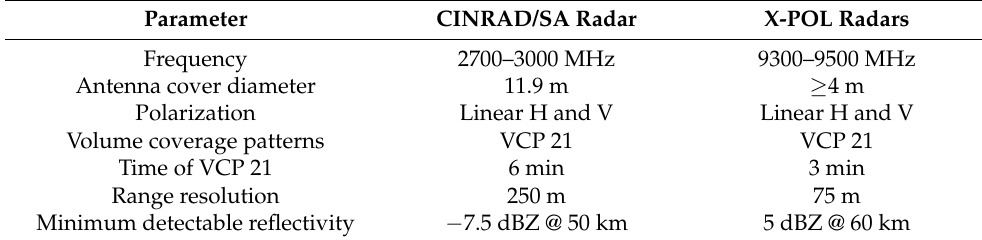
Figure 1. Distribution of radars (square signs and diamonds) and topography (coloring) of Beijing and its vicinity. The three square signs indicate the locations of the three X-POL radar sites (XFS, XSY, and XTZ). The diamond shows the location of the SDX site. The distance of each X-POL radar relative to the SDX site is labeled. The black dotted circle is the distance circle of the S-band with a 58 km radius, and the radius of the white dotted circles of the X-POL radar sites are 34 km, respectively. These circles show the detection zones of the CINRAD/SA and X-POLs where their minimum detectable reflectivity is less than − 5 dBZ. Table 2. System characteristics of the CINRAD/SA radar and the X-POL radars.